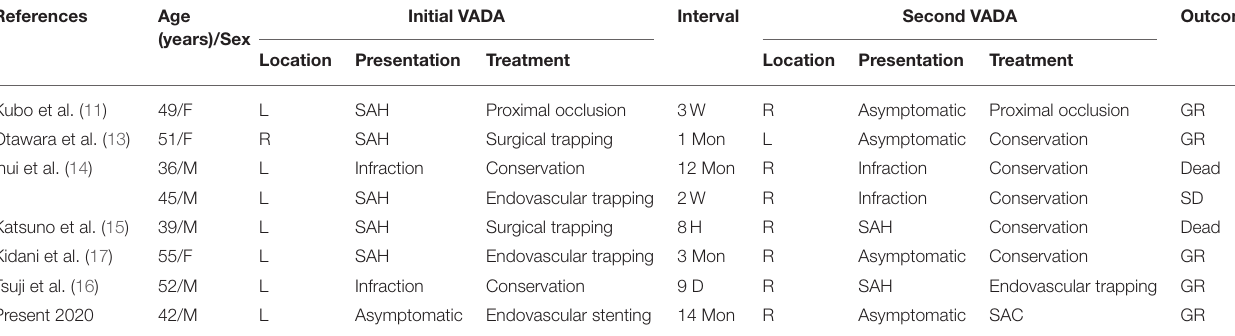
TABLE 1 | A summary of case reports of de novo VADA after the treatment of the contralateral